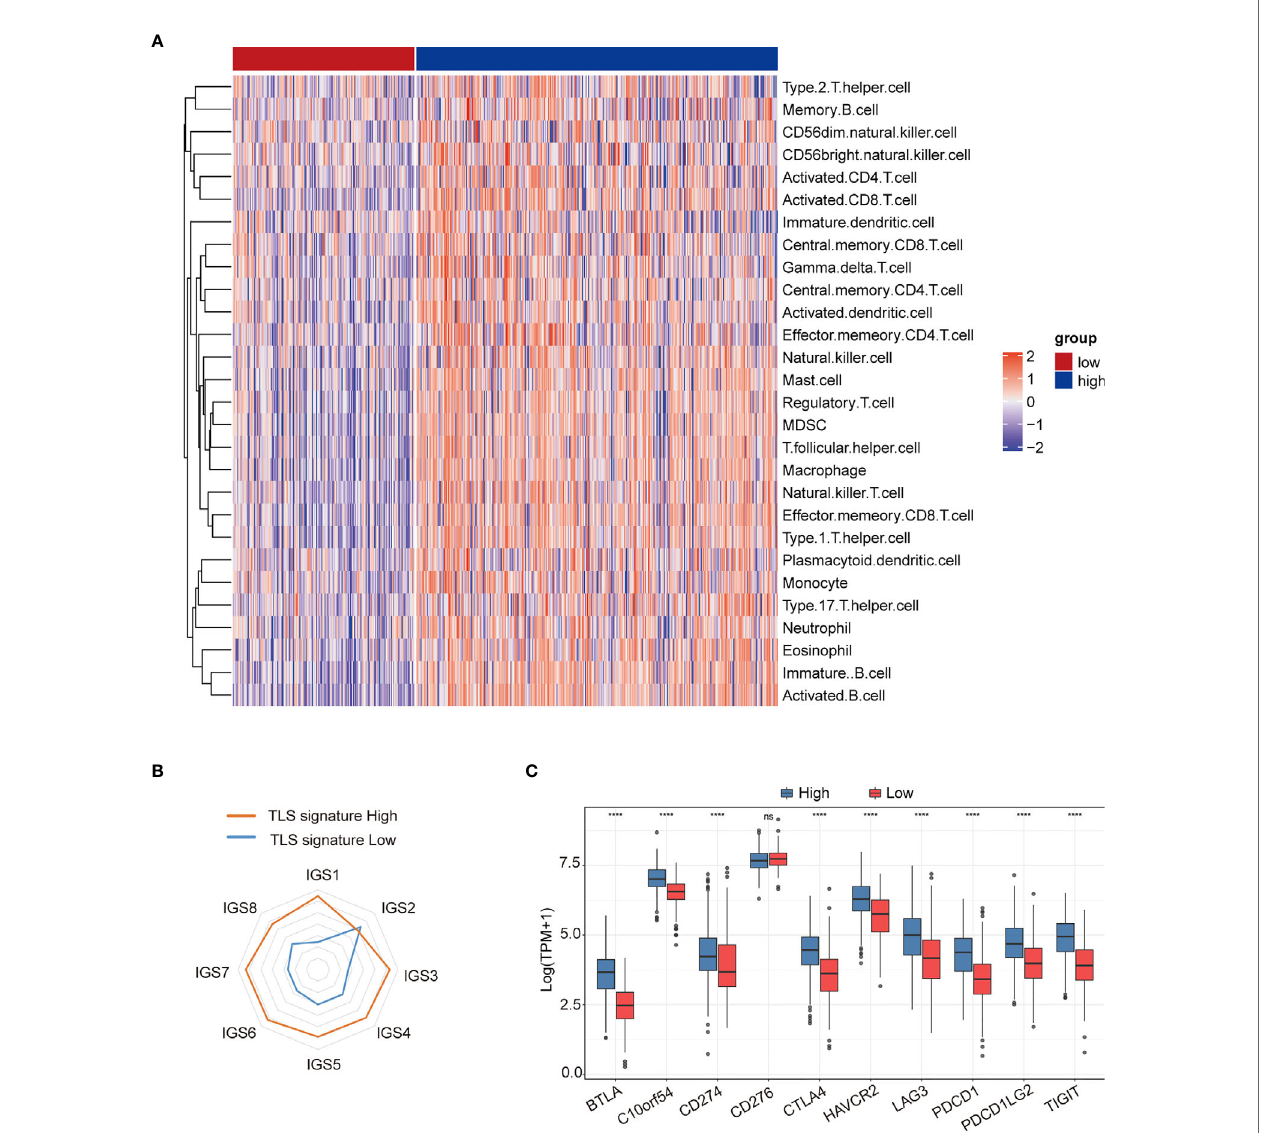
FIGURE 2 | Relationship between TLS signature and tumor immune microenvironment. (A) Differences in immune cell subsets between the TLS signature high (n = 337) and low (n = 169) groups; (B) Differences in cancer immune circulation between the TLS signature high (n = 337) and low groups (n = 169); (C) Differences in the expression of checkpoint genes between the TLS signature high (n = 337) and low groups (n = 169). Wilcoxon text, ****P < 0.0001; ns, not signi fi